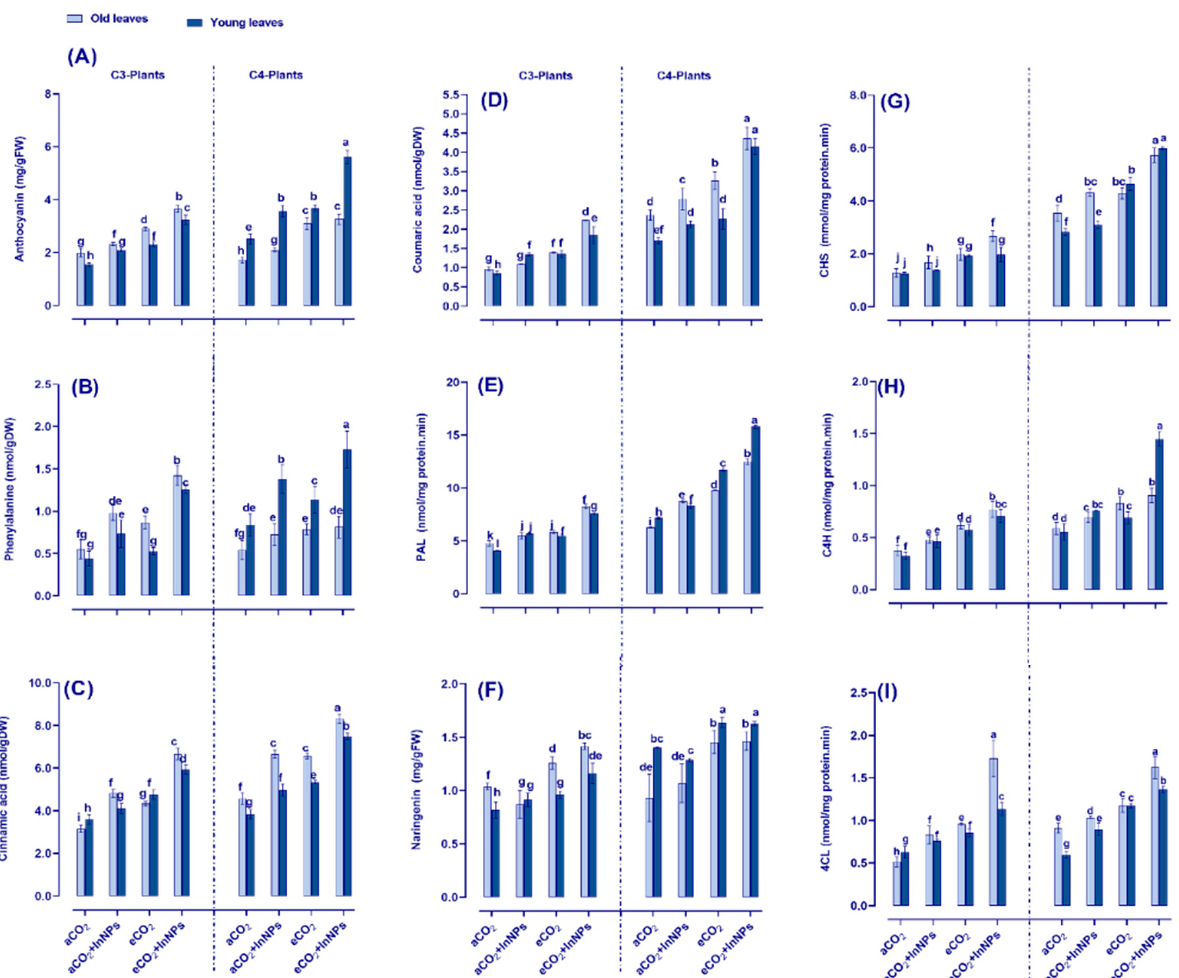
Figure 5. Effect of In 2 O 3 -NPs either alone or in combination with eCO 2 upon ( A ) anthocyanin, ( B ) phenylalanine, ( C ) cinnamic acid, ( D ) coumaric acid, ( E ) phenylalanine ammonia lyase; PAL, and ( F ) naringenin as well as the activities of ( G ) chalcone synthase; CHS, ( H ) cinnamate-4-hydroxylase; C4H, and ( I ) 4-coumarate CoA ligase; 4CL of both old and young leaves of C3 and C4 plants. Four biological replicates are used to demonstrate each value. The vertical error bar represents the standard error (SE). Fisher’s LSD test ( p < 0.05; n = 4) was used to compare the data for each response separately. Different letters indicate significant differences between means in young and old leaves of C3 or C4 plants.